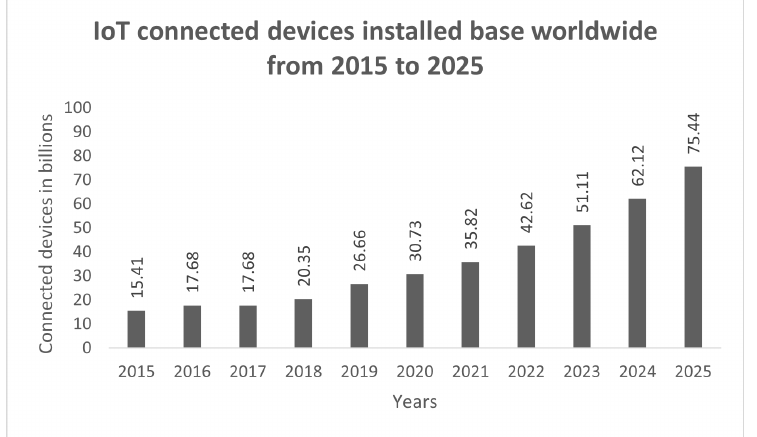
Figure 1. Growth of IoT devices from 2015 to 2025